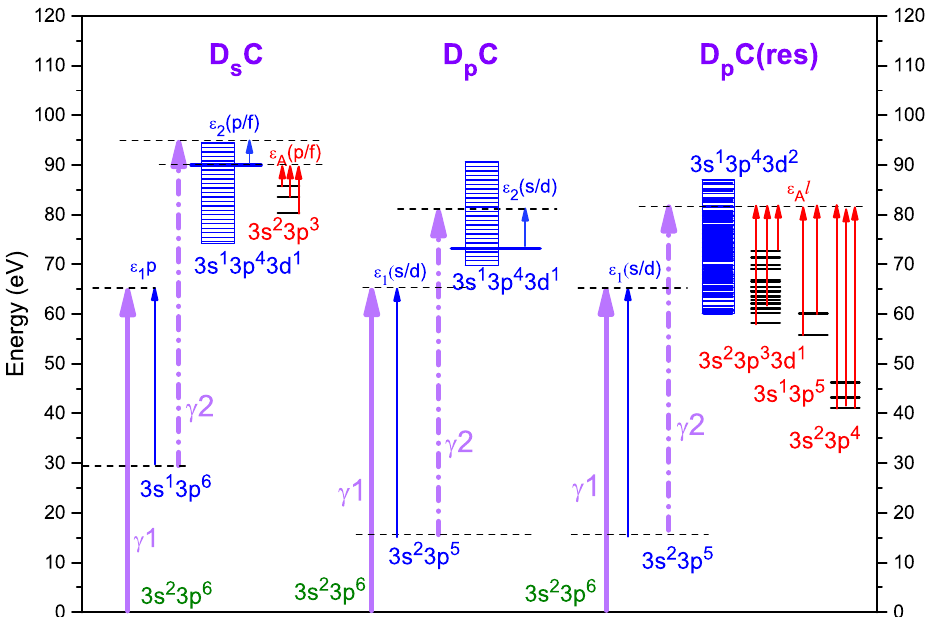
Figure 2. Energy schemes of the sequential two-photon double ionization of argon with a correlational process at the second ionization step. Designations are the same as in Figure